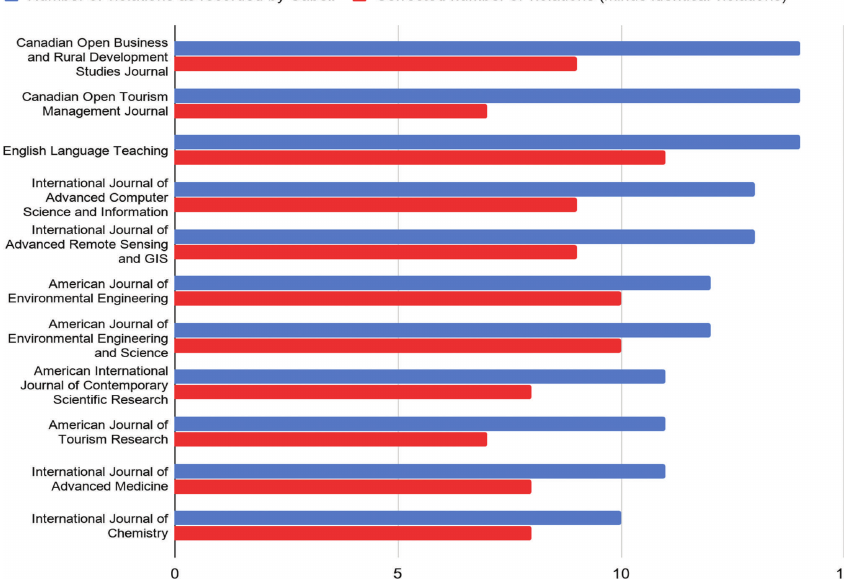
Fig. 5: Journals that we observed containing identical violations recorded multiple times, with their corrected number of